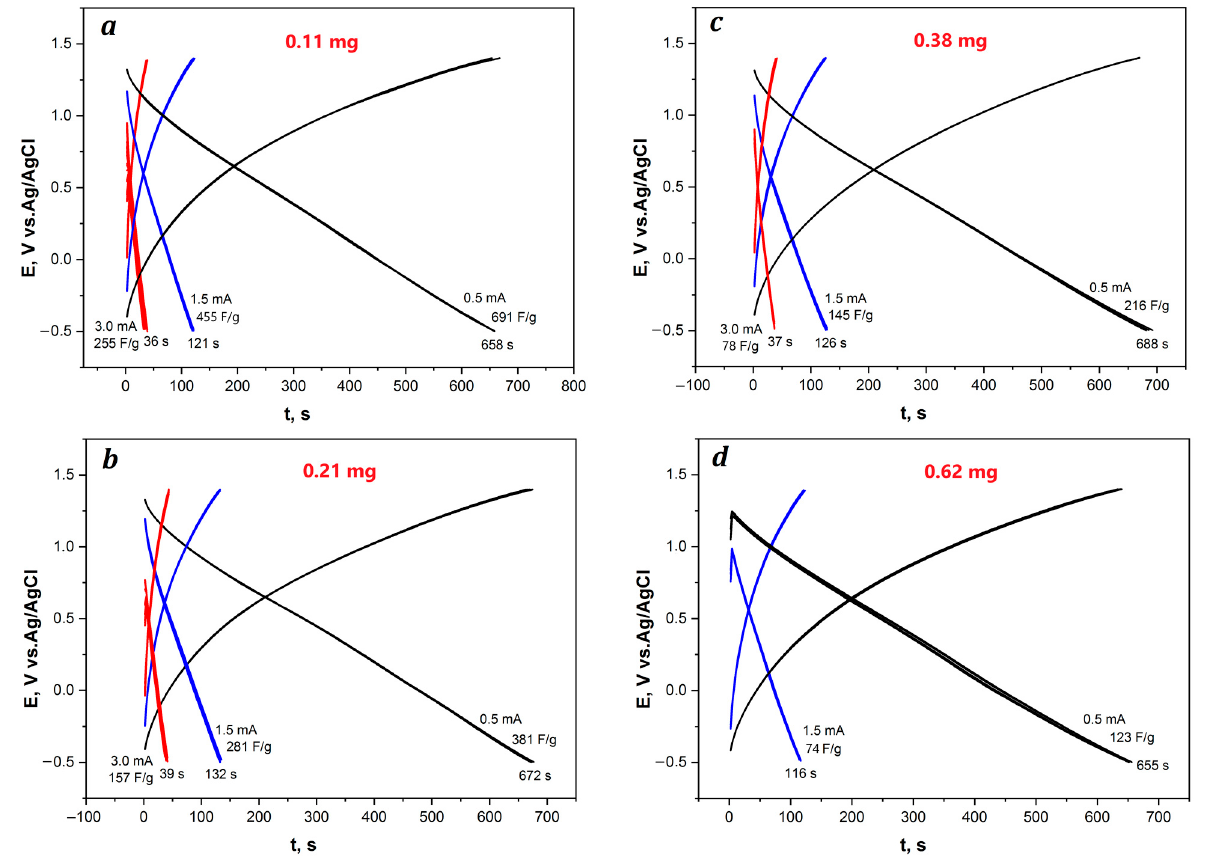
Figure 13. Galvanostatic charge–discharge dependencies of the AGF/RGO/P-N-PAA-1 IR electrodes with coatings weight of 0.11 ( a ), 0.21 ( b ), 0.38 ( c ) and 0.62 mg ( d ).